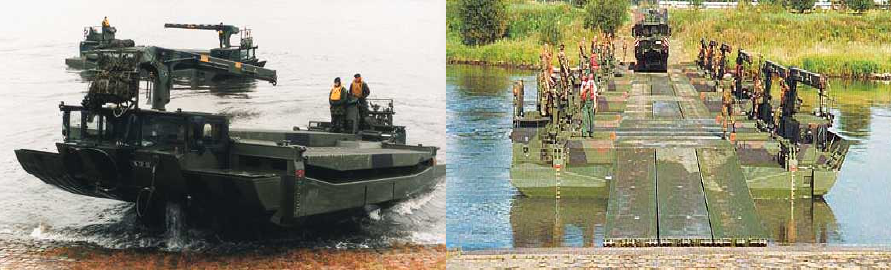
Figure 6 – German amphibious ferry